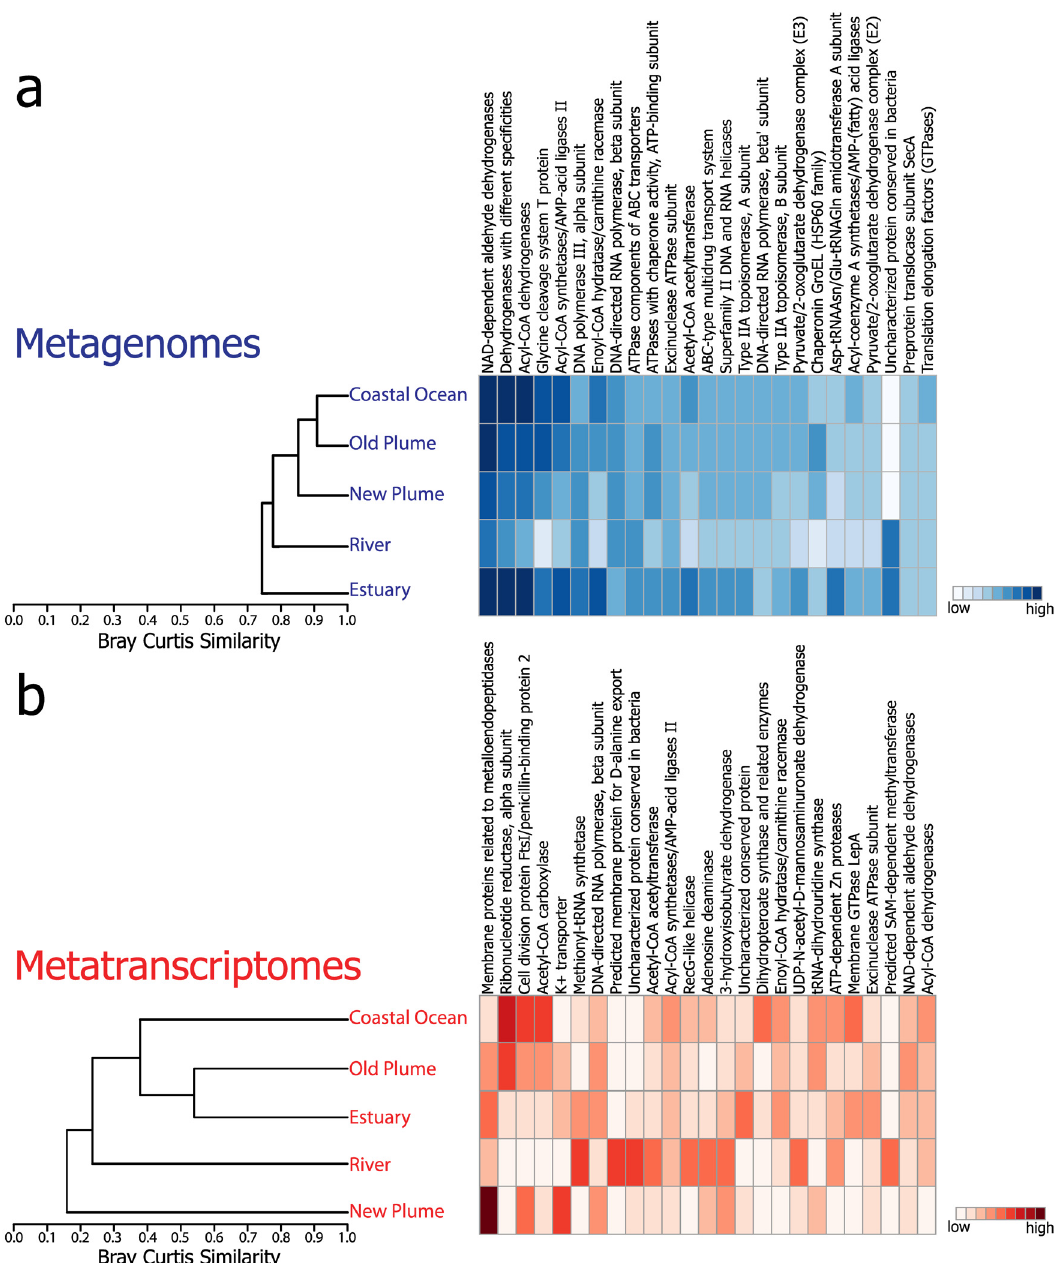
Fig 3. Hierarchical clustering of samples across salinity. Dendrogram and heatmap of a) metagenomes and b) metatranscriptomes based on the normalized abundance of COG functions. Heatmaps depict the top twenty-five most abundant COGs.